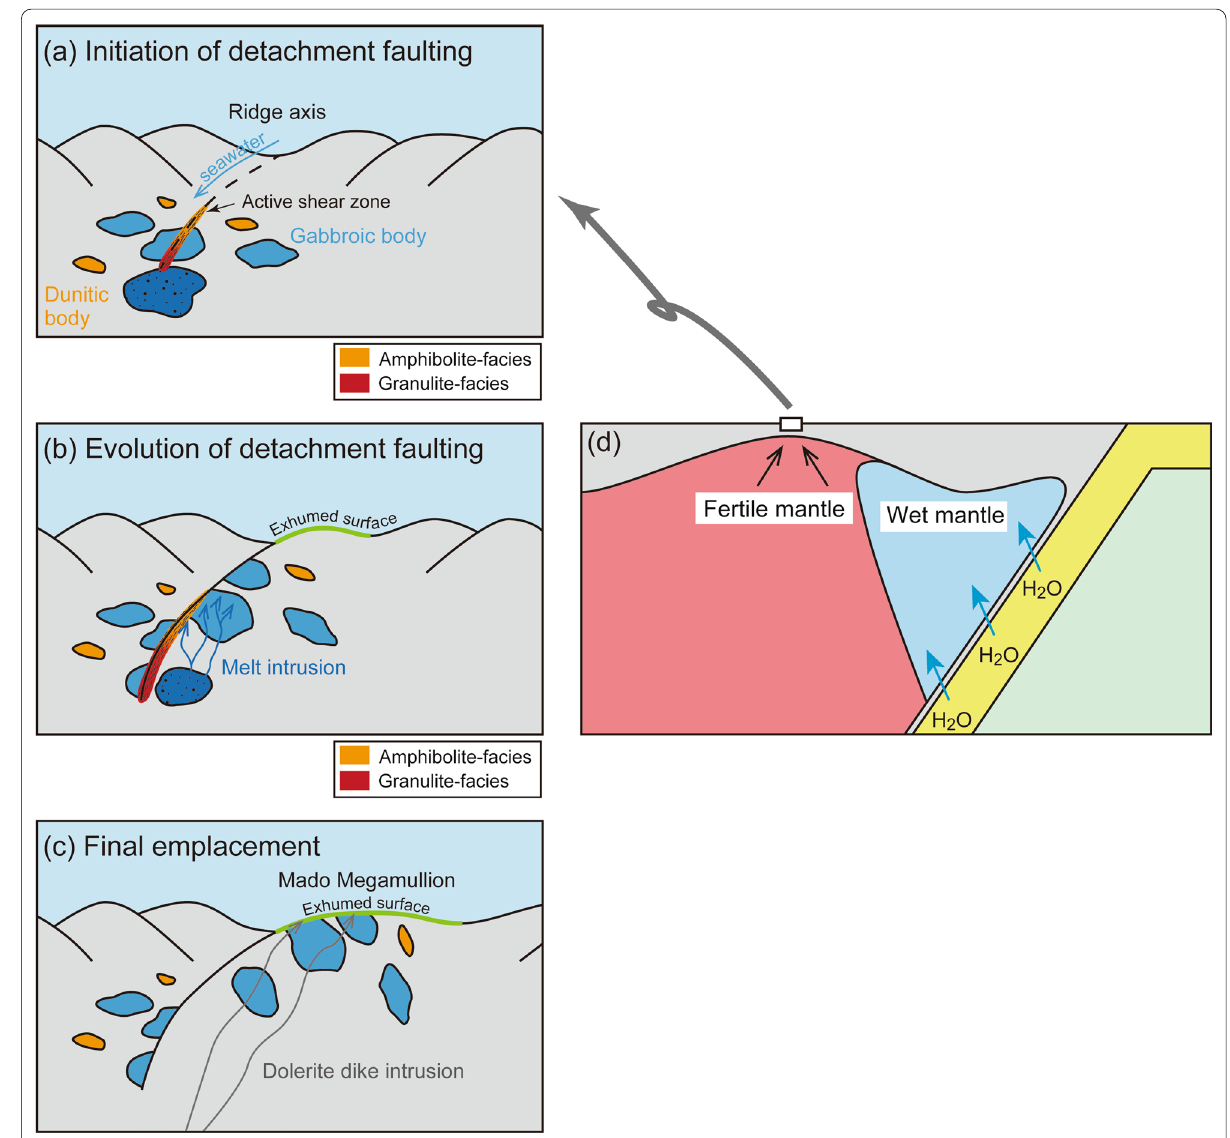
Fig. 11 Schematic models for the evolution of Mado Megamullion. a Deep‑seated formation of the dunites and gabbros. b Mafic to felsic melt intrusion during the progressive exhumation of the Mado Megamullion. c Dolerite dike intrusion at the final emplacement of the Mado Megamullion. d A concept of matured back‑arc spreading during the formation of Mado Megamullion. Fertile mantle without subduction‑related elemental input is the source of melt forming the Mado Megamullion. a – c were modified after Basch et al.